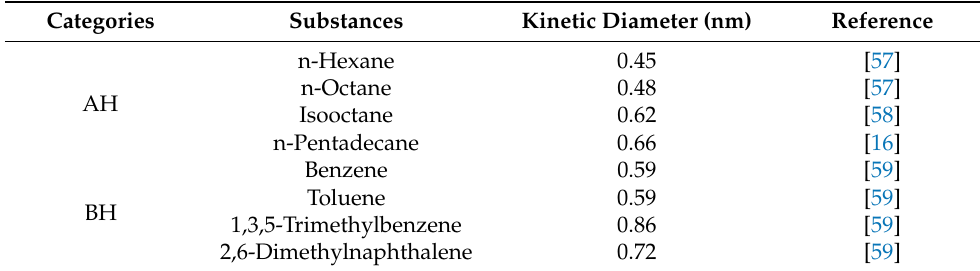
Table 5. Reported values of kinetic diameter for some VOCs